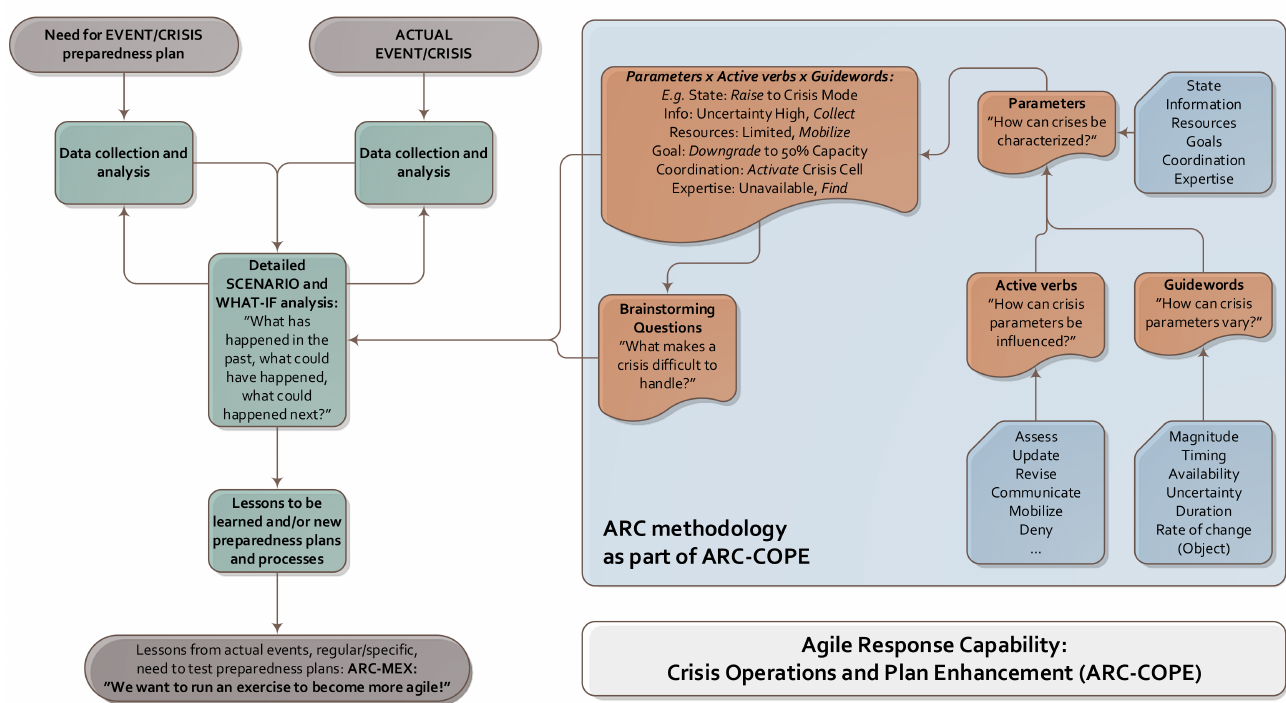
Figure 3. Overview of ARC Crisis Operations and Plan Enhancement: